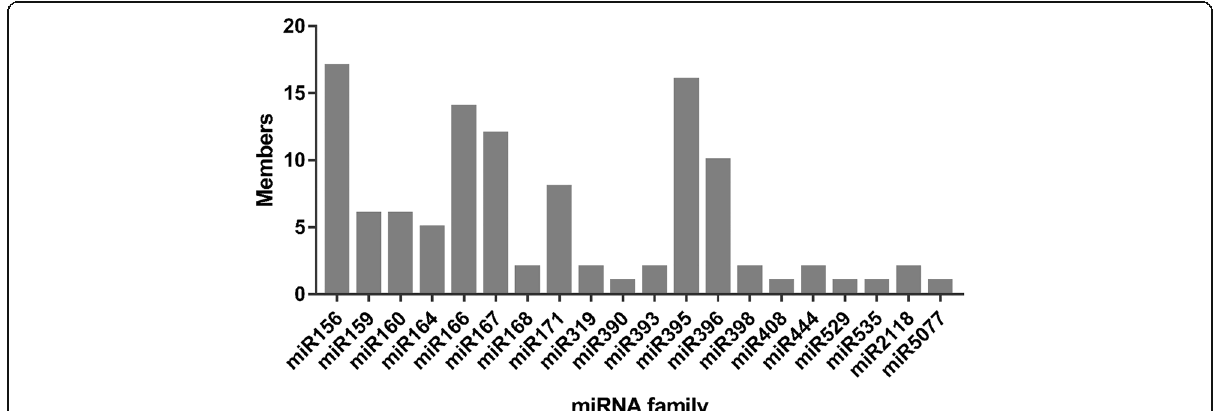
Fig. 1 Number of miRNA members belonging to the miRNA families found in this study. The miRNA families listed on the X-axis are the identified miRNA families in the twelve sRNA libraries. Among them, miR156, miR395, miR166 and miR167 possessed the most members present